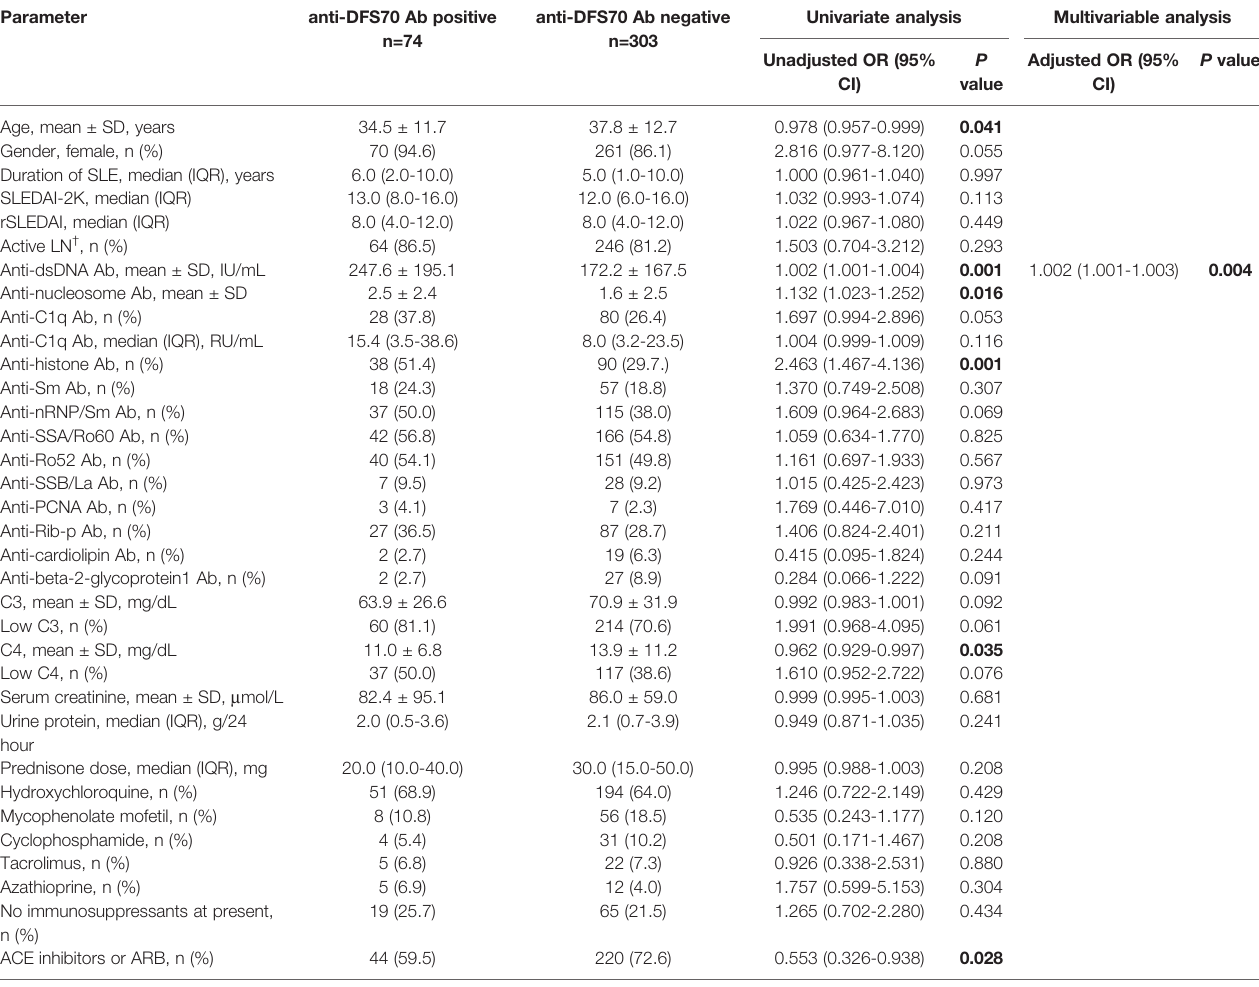
TABLE 1 | Comparisons of 377 LN patients with and without anti-DFS70 antibodies. Parameter